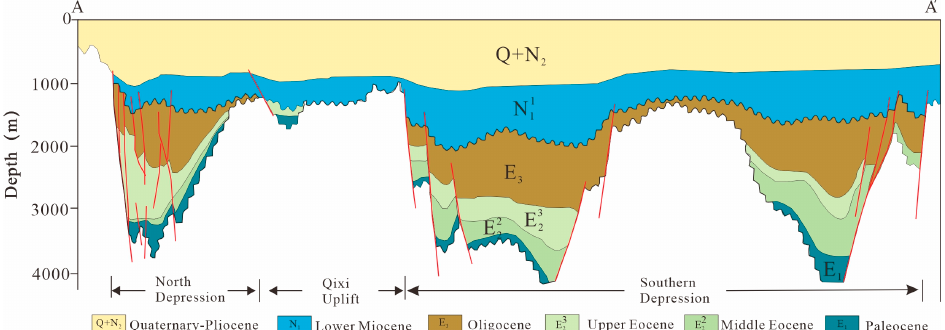
Figure 2. Geological section of the Beibu Gulf Basin (modified after [28]). See Figure 1 for the profile location. profile